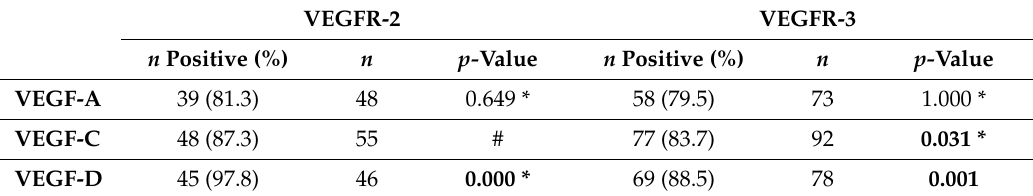
Table 6. Assessment of associations between expression of VEGF-A, VEGF-C and VEGF-D and the receptors VEGFR-2 and VEGFR-3 in lymph node metastasis of CRC. * Examined for statistical significance using Fisher’s exact test (when n < 5). In bold the significant results.